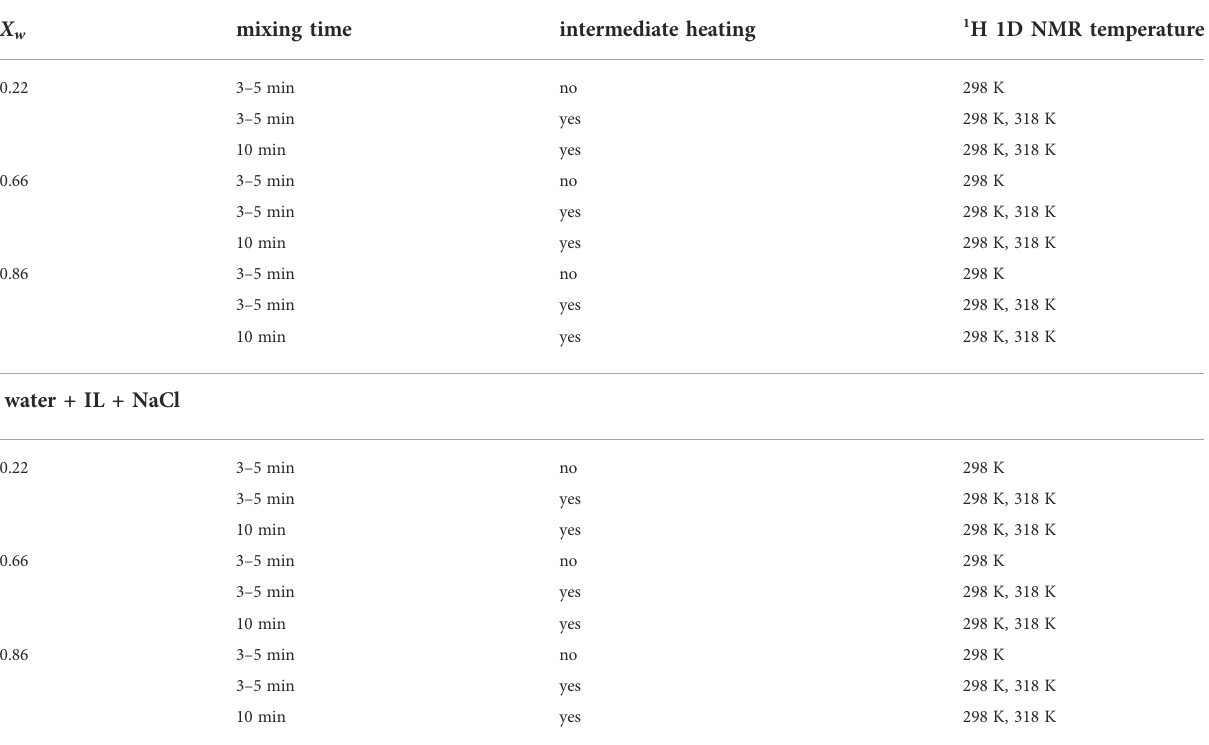
TABLE 1Details of the mixing protocols applied during the sample preparation, specifying the mixing order (water + NaCl + IL and water + IL + NaCl), molar fraction of water ( X w ), mixing time, intermediate heating of the sample (from 298 K to 318 K) and temperature of the 1 H 1D NMR